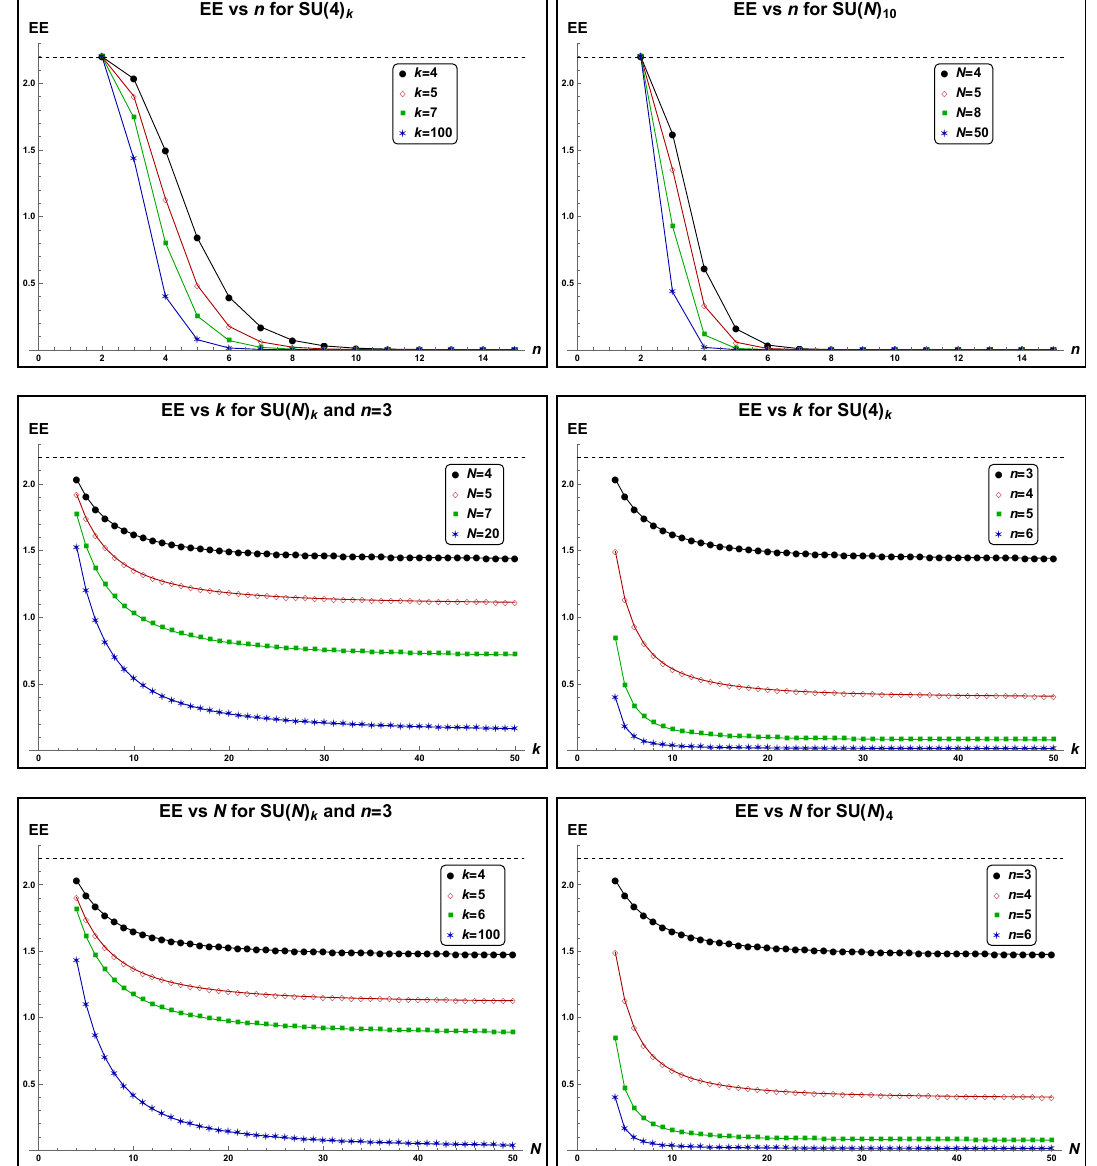
Figure 10 . The variation of SU( N ) k entanglement entropy when the Wilson lines carry adjoint representation. The (cid:12)rst two plots show that EE ! 0 for n (cid:29) 1. The other four plots show that entropy decreases and converges to a (cid:12)xed value as k ! 1 or N ! 1 respectively.